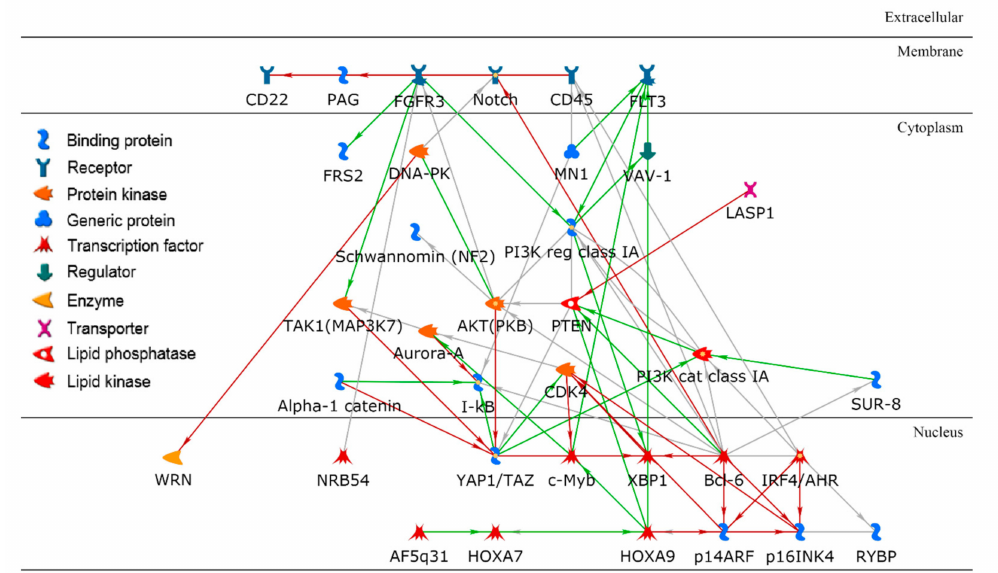
Figure 6. A protein–protein interaction network using a set of key gene products in a paired cluster of cell lines and drugs. Bcl-6 is a hub in the network with the highest node